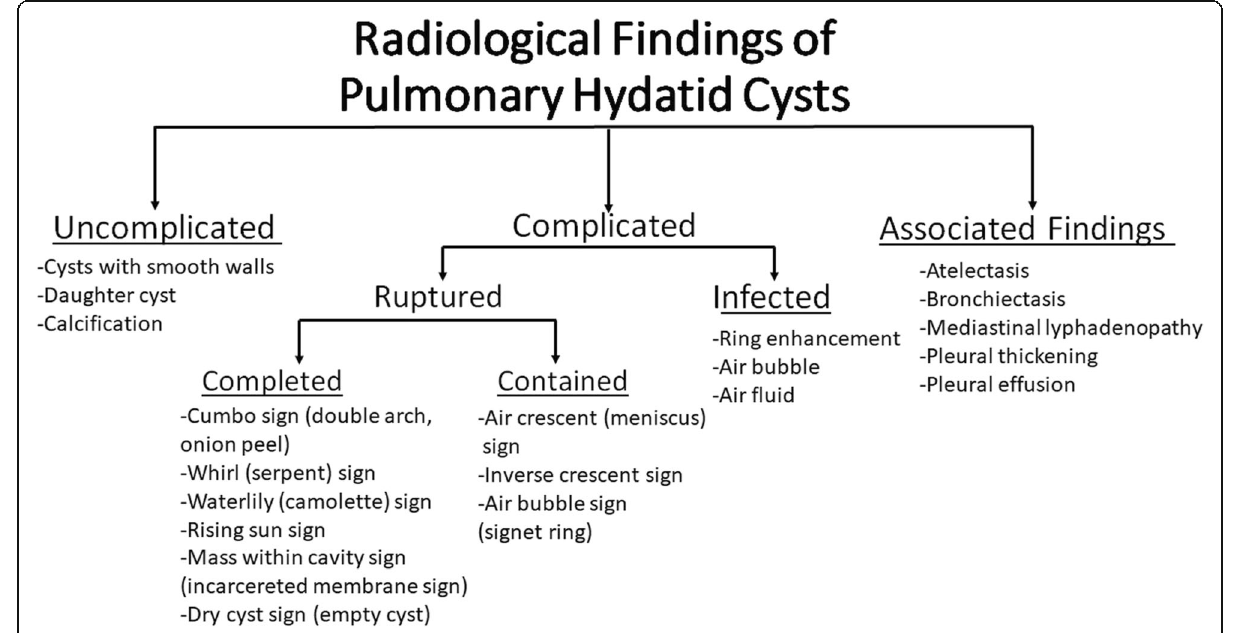
Fig. 3 Radiological findings of pulmonary hydatid